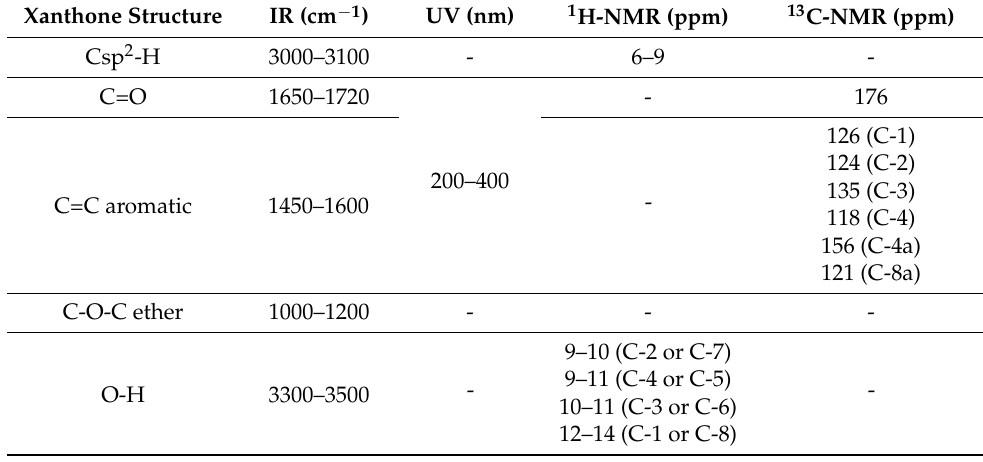
Table 1. A brief summary on the structure elucidation of xanthones using spectroscopy